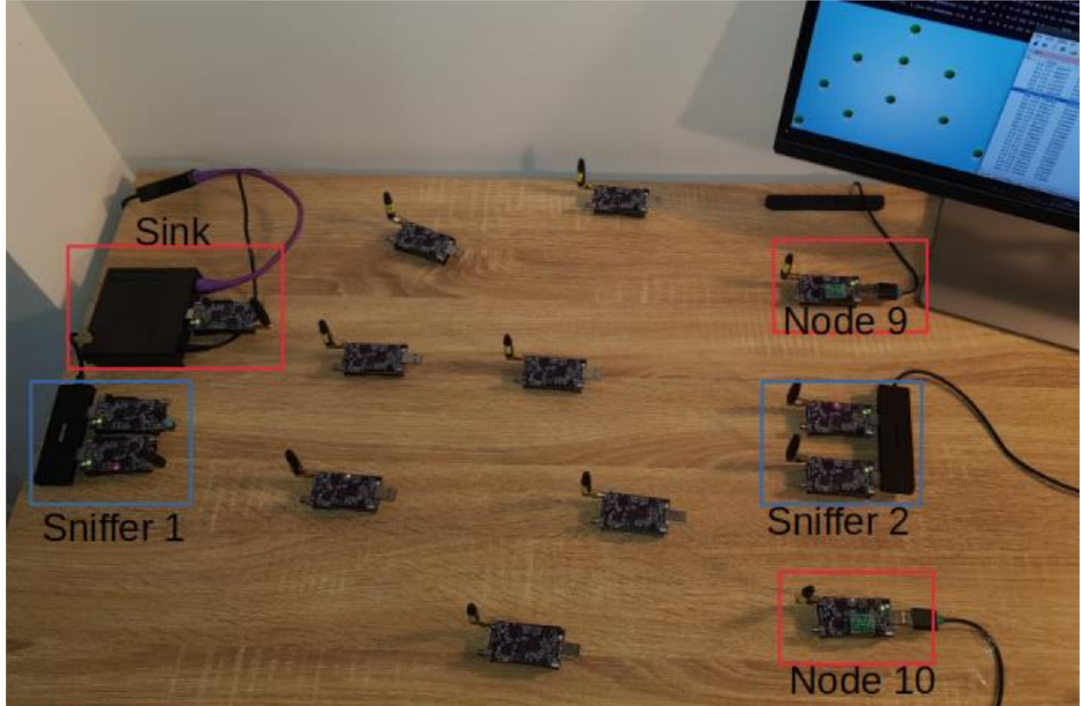
Figure 16. Testbed for 10 nodes